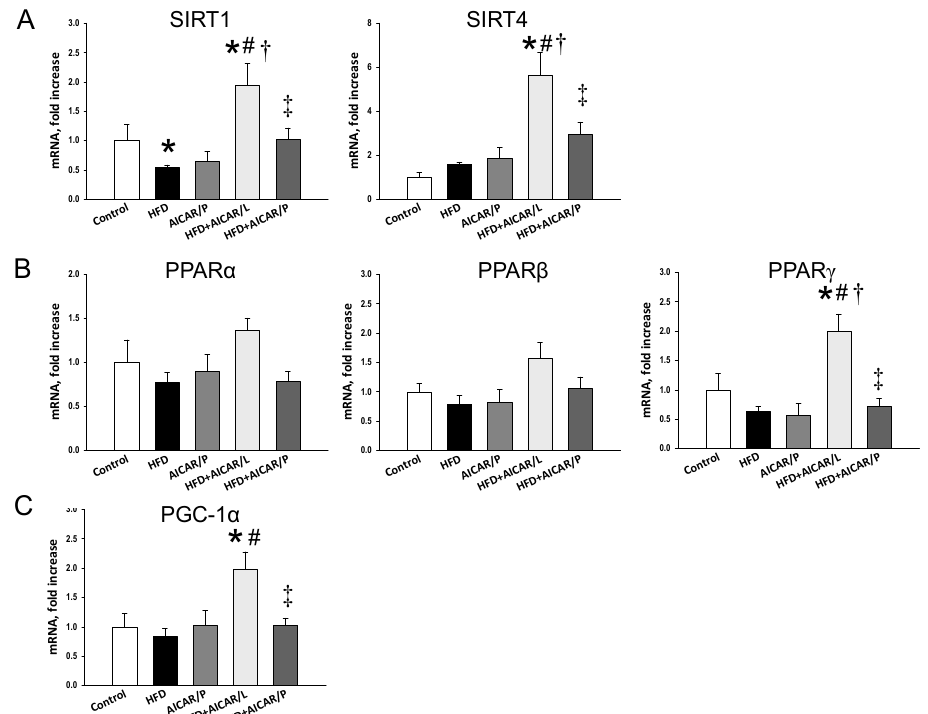
Figure 4. Effect of high-fat diet (HFD) and AICAR treatment in pregnancy (AICAR/P) or lactation (AICAR/L) on mRNA expression of ( A ) silent information regulator transcript 1 (SIRT1) and 4 (SIRT4); ( B ) peroxisome proliferator-activated receptor (PPAR) α -, β -, and γ -isoforms; and ( C ) PPAR γ coactivator-1 α (PGC-1 α ) in 16-week-old male offspring kidneys. * p < 0.05 vs. control, # p < 0.05 vs. HFD, † p < 0.05 vs. AICAR/P, ‡ p < 0.05 vs. HFD + AICAR/L.